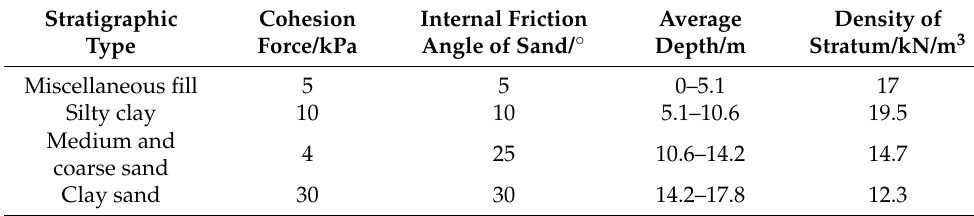
Table 2. Classification table of different strata.